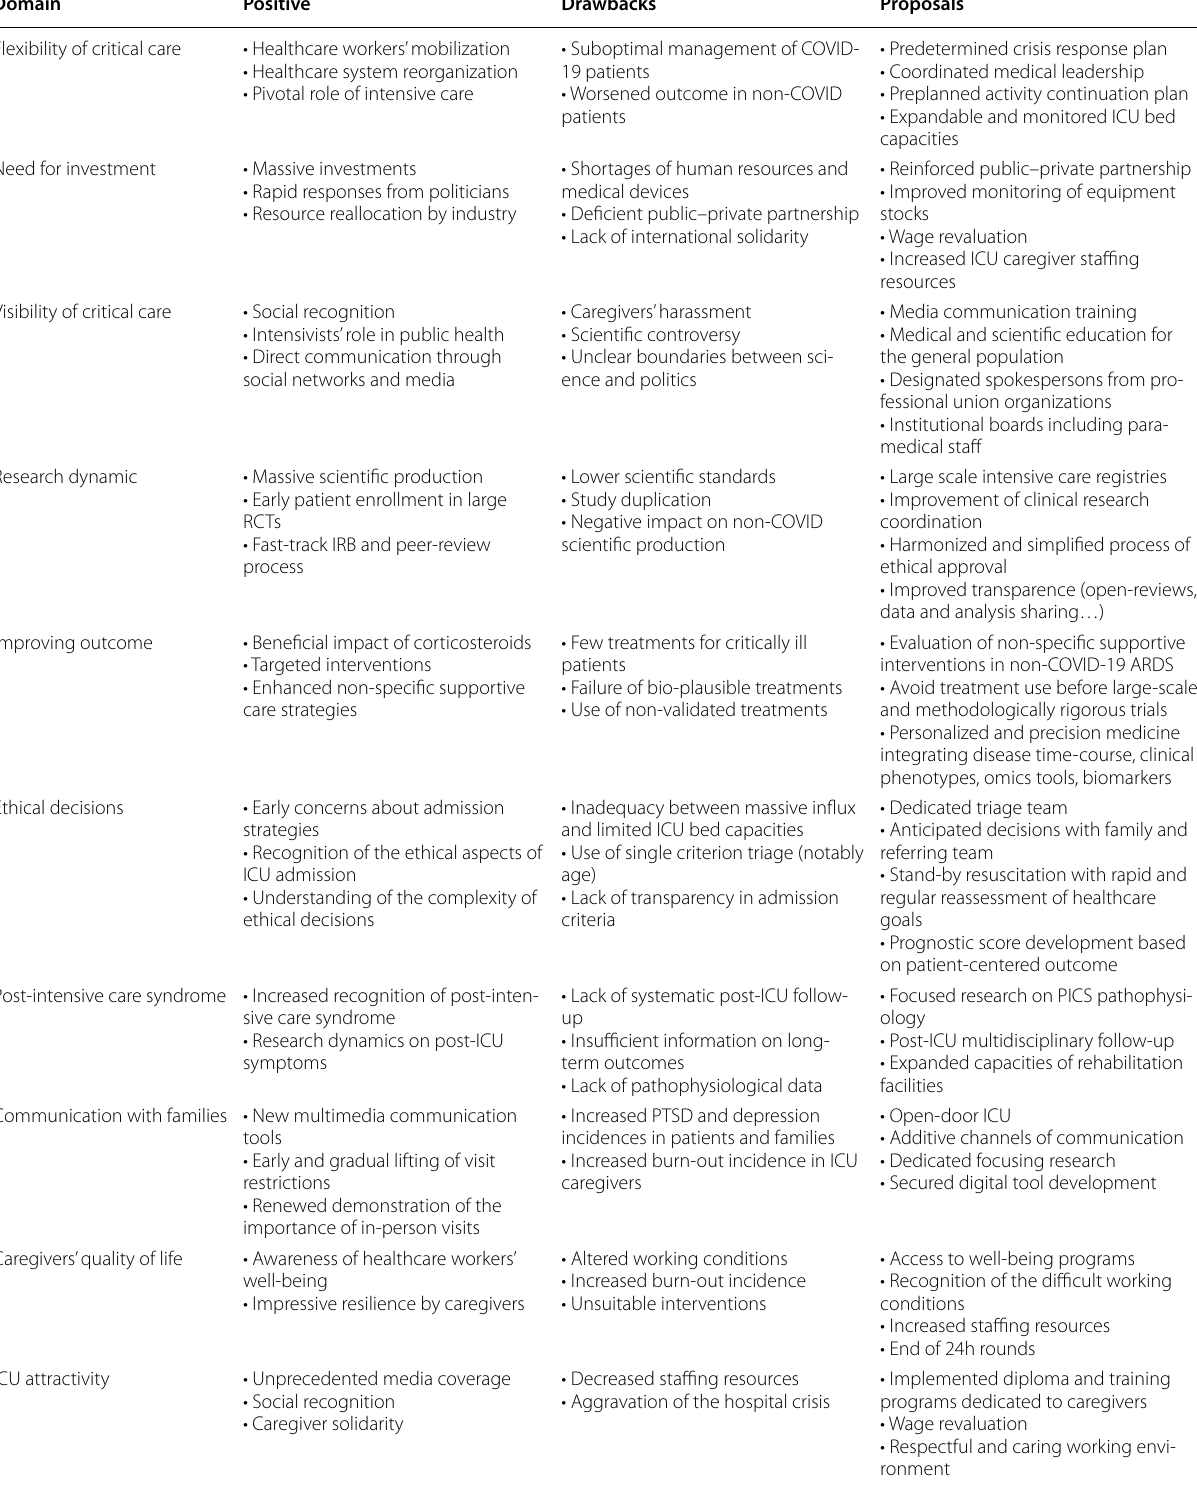
Table 1 Impact and potential legacy of the COVID-19 pandemic on critical